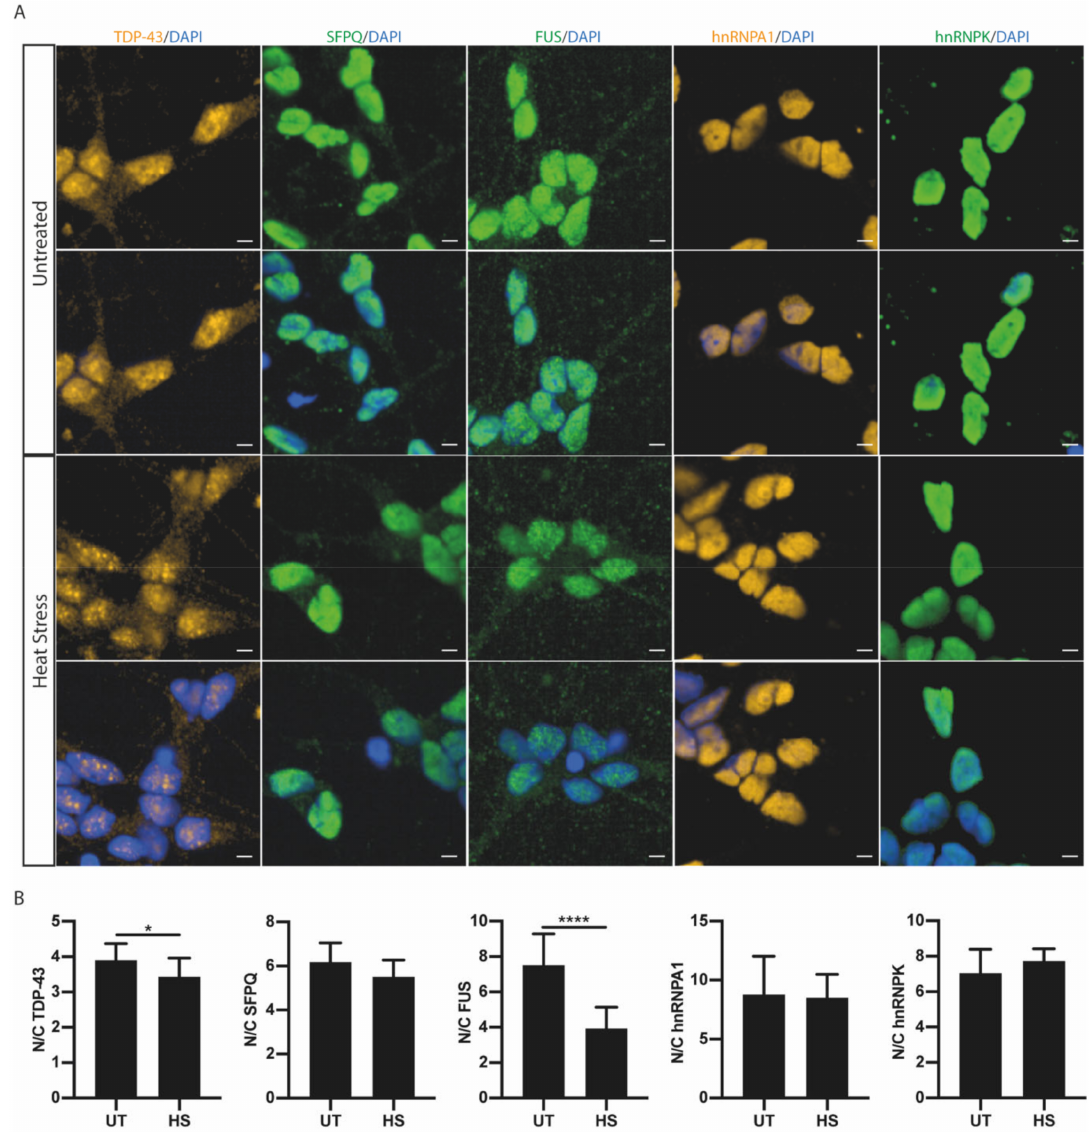
Figure 3. Heat stress causes stress-specific changes in nucleocytoplasmic distribution. ( A ) Representative images of TDP-43, SFPQ, FUS, hnRNPA1 and hnRNPK in iPSC-derived motor neurons in untreated and heat stress conditions, defined as 1 h at 42 ◦ C. Scale bars = 5 µ m. ( B ) Individual cell quantification of the nuclear / cytoplasmic ratio identified a significant loss of the nuclear / cytoplasmic ratio in TDP-43 and FUS under heat stress, with a small decrease in the nuclear / cytoplasmic ratio for SFPQ, but no e ff ect on hnRNPK or hnRNPA1. Data shown are mean nuclear / cytoplasmic ratios ( ± SD) per well from > 7000 cells from 3 control lines in 2 independent experimental repeats. p -value from unpaired t -test; * = p < 0.05; **** = p <